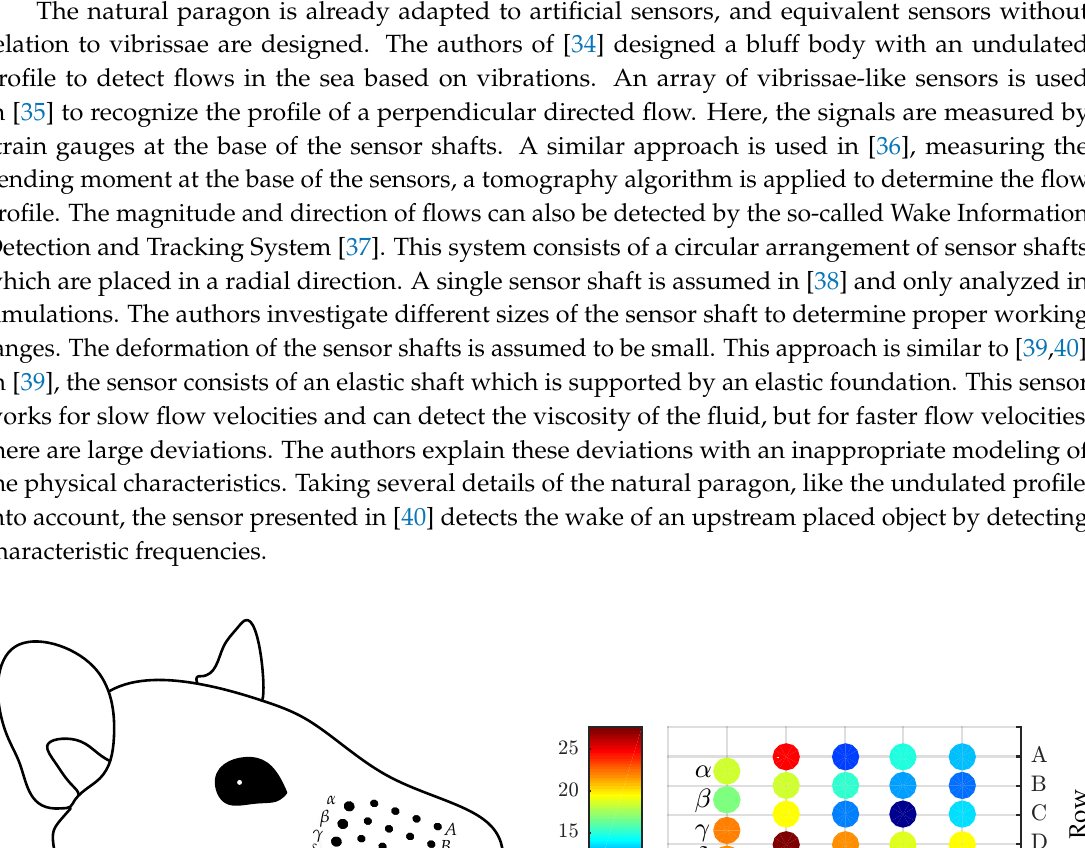
. Here, s , the density m 3 s